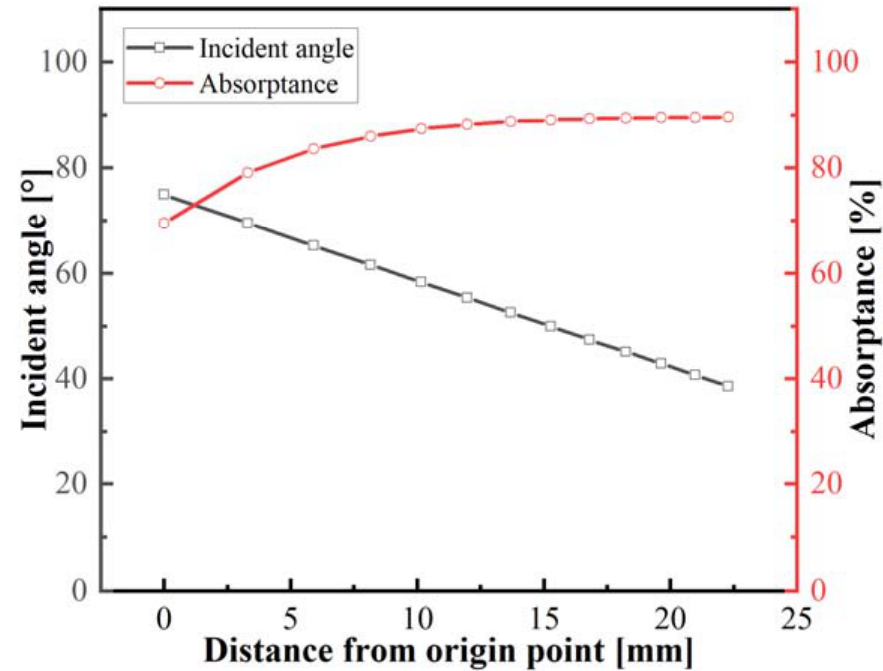
Figure 8. The effect of distance from the origin on incident angle and absorptance.